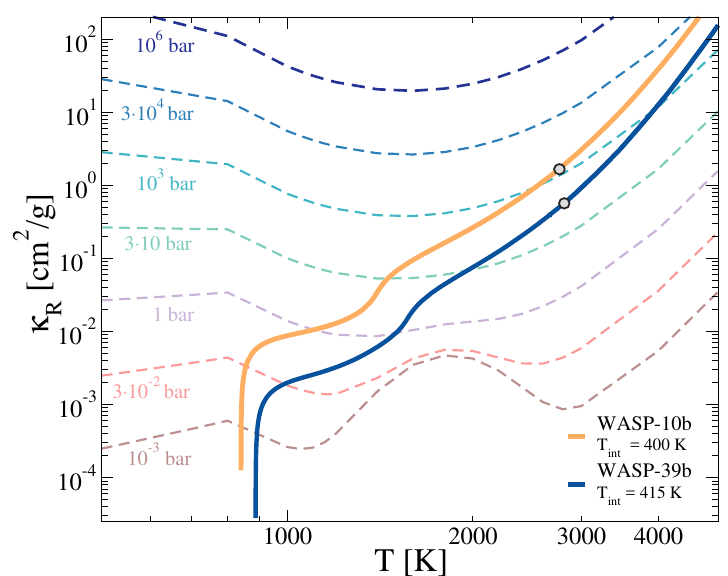
Figure 2. Fit of Valencia et al. [39] to the Rosseland mean opacities κ R of Freedman et al. [40] along isobars (dashed) and κ R along the present P – T profiles for WASP-10b (solid orange) and WASP-39b (solid blue). The transition from the atmosphere to the interior is marked by grey